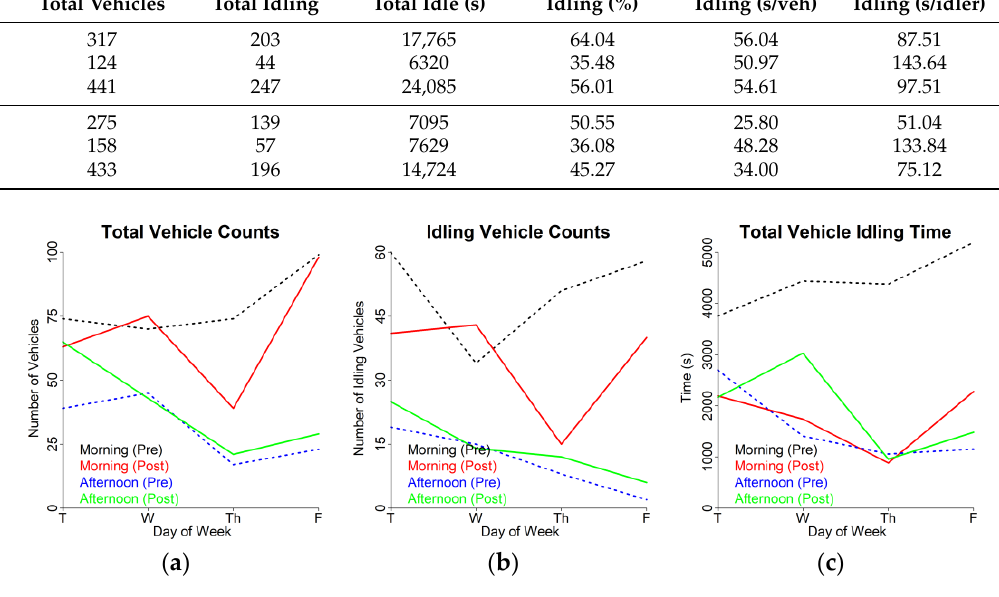
Figure 12. Weekday time of day pre- and post-campaign: ( a ) total vehicle counts, ( b ) idling vehicle counts, and ( c ) total vehicle idling time.